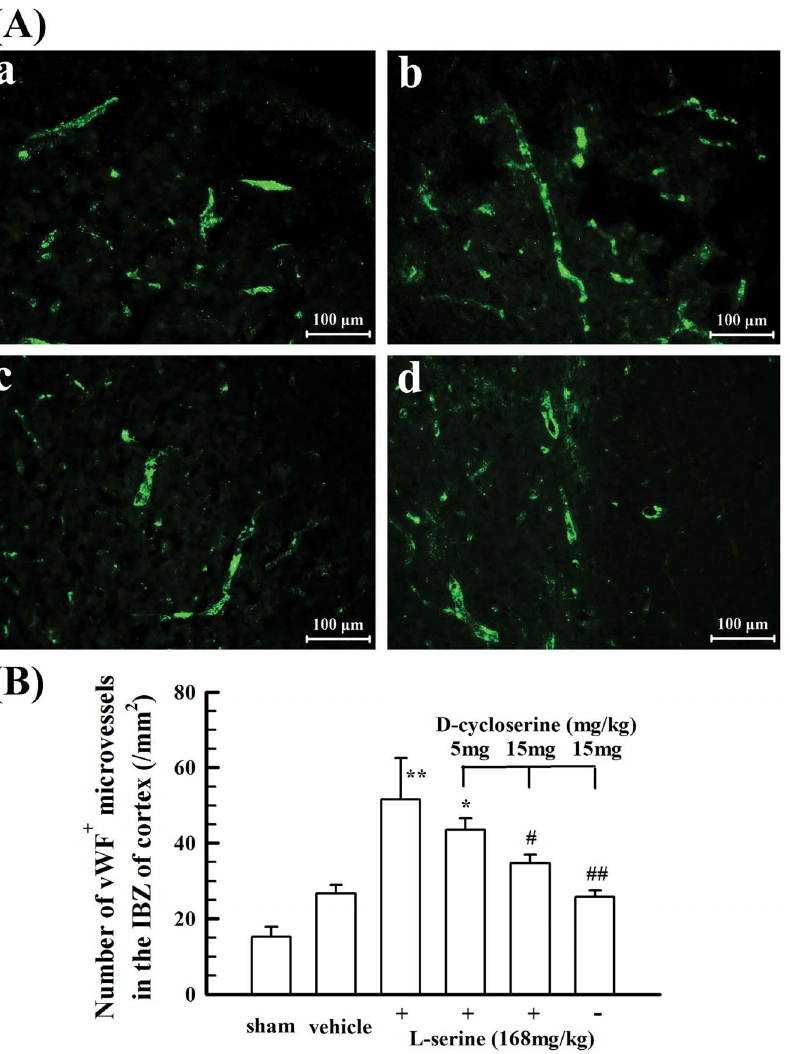
Figure 8. Effect of L-serine treatment on the number of microvessels in the IBZ of cortex 5 days after pMCAO. (A) Representative examples of vWF-positive microvessels: a, vehicle group; b, L-serine (168 mg/kg) treated group; c, L-serine (168 mg/kg) plus D-cycloserine (15 mg/kg) treated group; d, D-cycloserine (15 mg/kg) treated group. (B) Mean values of the microvessel number in the IBZ of cortex in different group rats (n=4). * p , 0.05, ** p , 0.01 vs . vehicle group; # p , 0.05, ## p , 0.01 vs . L-serine-treated